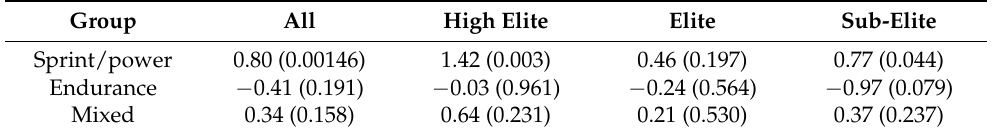
Table 8. Association of diplotypes with athletic status (case vs. control) using a generalised linear model, stratified by sport discipline and athletic performance, and adjusted for sex. Group All High Elite Elite Sub-Elite